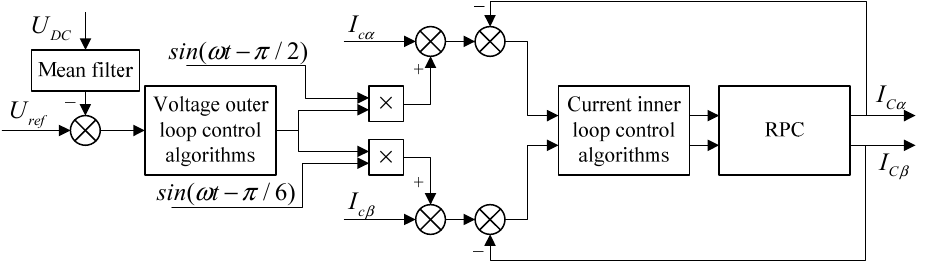
Figure 4. Control strategy of RPC.